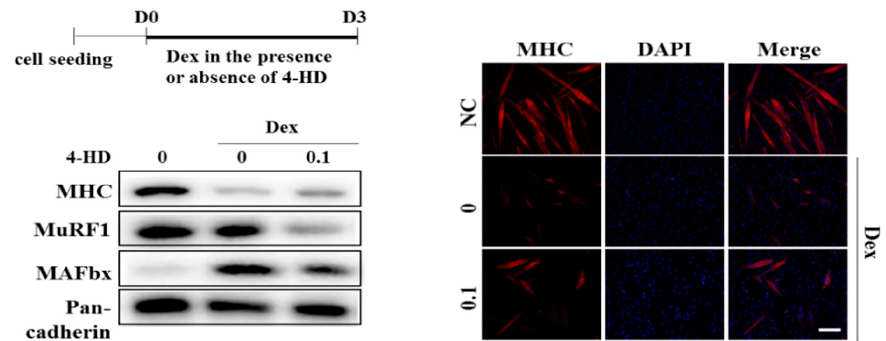
Figure 5. Protective effect of 4-HD against muscle wasting in vitro . C2C12 Cells were treated according to the scheme and expression levels of MHC and muscle E3 ligases were determined by Western blotting analysis. MHC and DAPI were immunostained in myotubes. Scale bar = 200 μ m. Secondly, differentiation of C2C12 myoblasts were induced into myotubes for 3 days with 30%